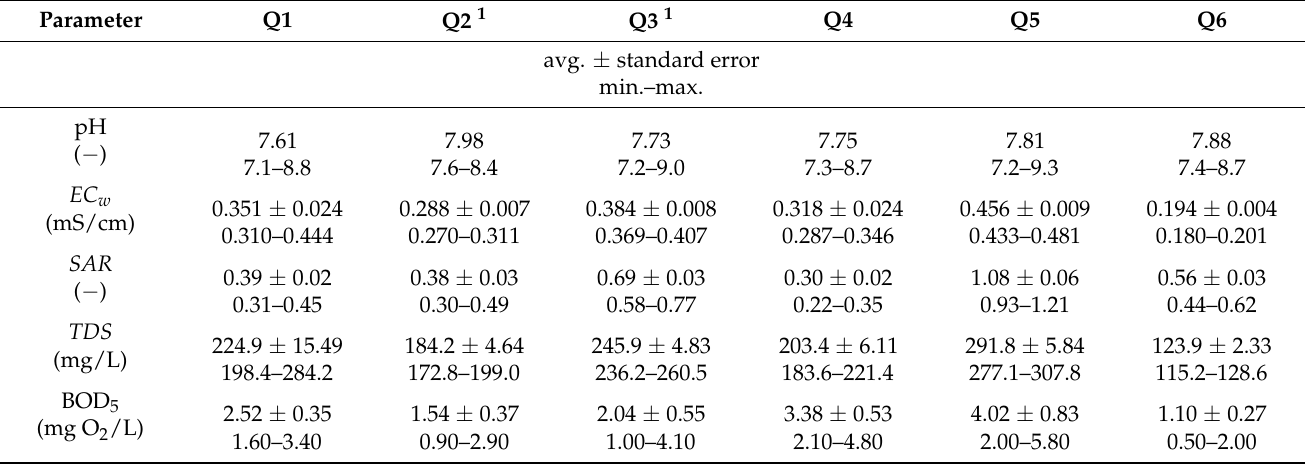
Table 3. Average, minimum and maximum value of the analysed water quality indicators in selected Strzelin granitoid quarry lakes (author